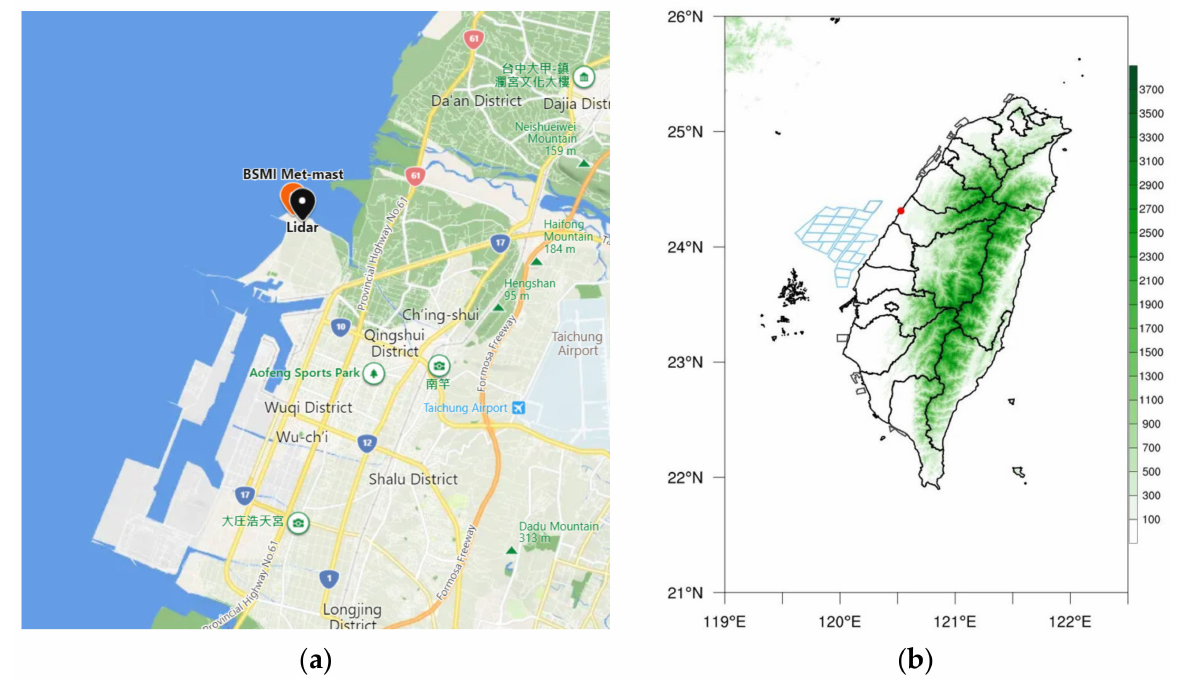
Figure 1. ( a ) Locations of the met mast (red pin) and the lidar (black pin); ( b ) The map of Taiwan. The red dot shows observation sites. The blue grid denotes the main area of offshore wind